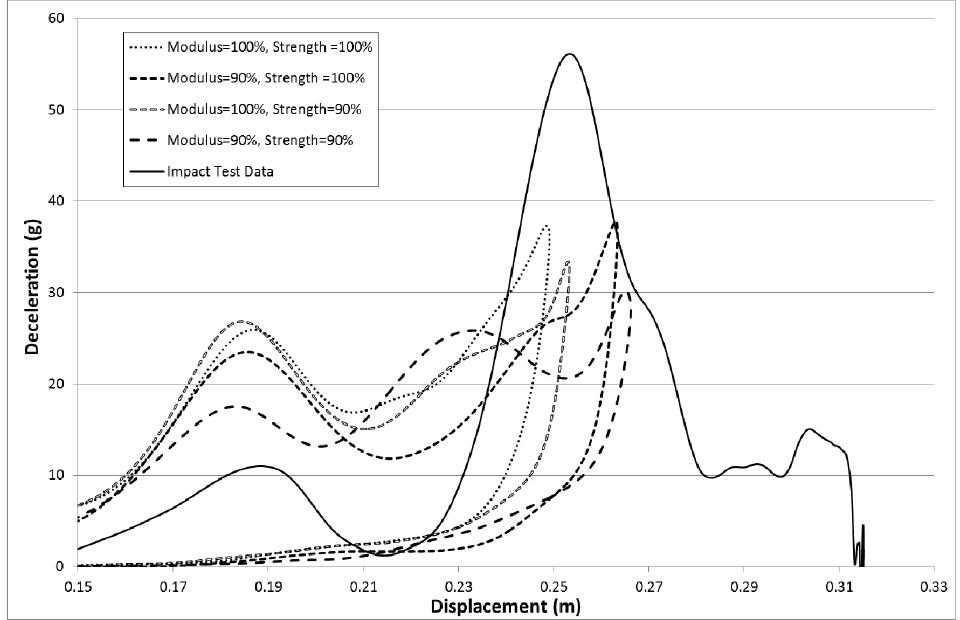
Figure 25. Effect of reducing modulus and failure strengths by 10% with All Slim = 1.0, TSize = 0.0, Erods = 0.0, Soft = 0.0 (no softening as TSize = 0.0) and FS = − 1.0.